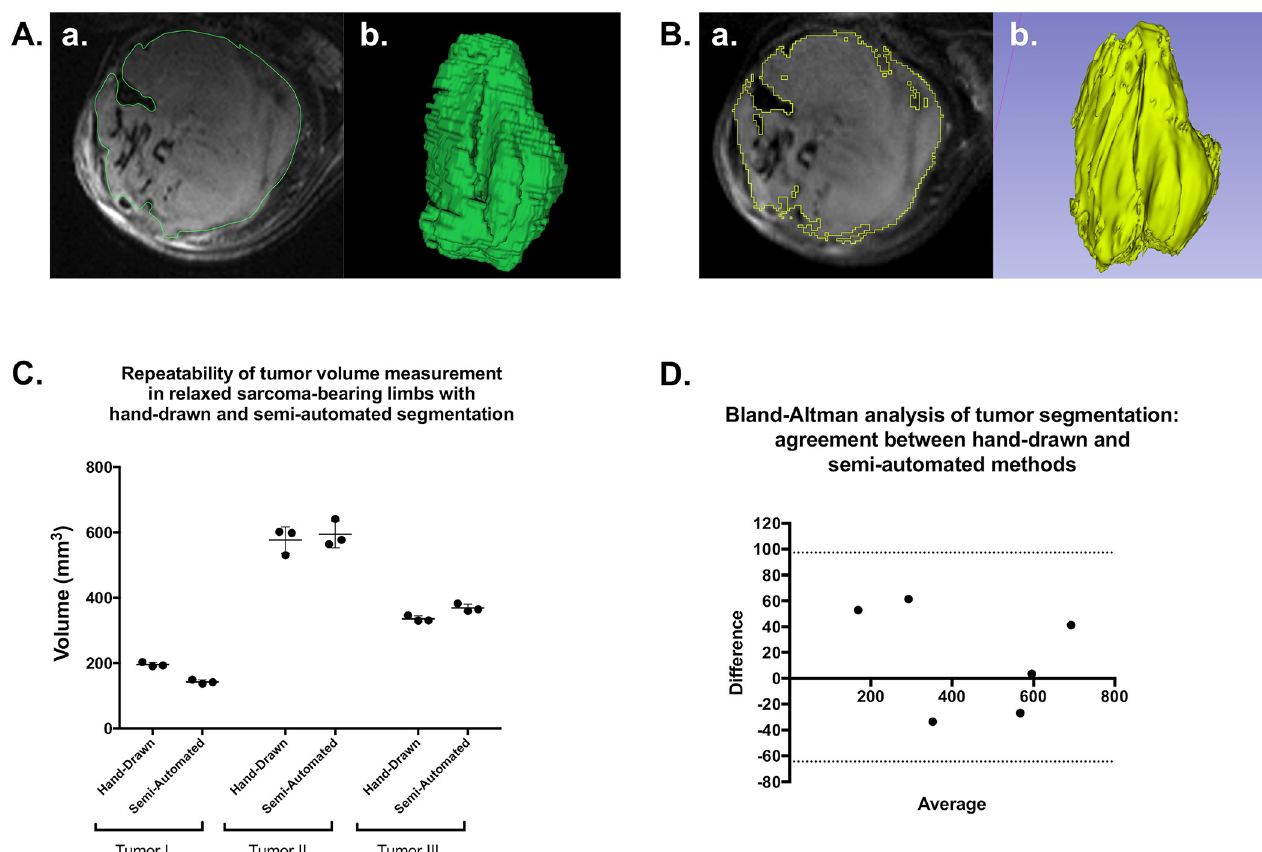
Fig 7. Semi-automated tumor segmentation with 3D Slicer is an acceptable alternative to hand-drawn ROIs for sarcoma volume measurement. T2-weighted images of three tumors of varying size and morphology were analyzed with hand-drawn ROIs and semi-automated segmentation to calculate tumor volume. Examples of hand-drawn (A) and semi-automated (B) segmentation of the same tumor are shown, including an axial slice of the segmented tumor (a.) and the rendered 3D representation of the tumor according to each segmentation (b.). Resulting volume calculations were compared between triplicate measures with each method for each tumor (C), demonstrating similar measurements and comparable precision. Bland-Altman analysis of both methods, when employed in 6 separate tumors, indicated that semi-automated segmentation is a viable alternative to hand-drawn segmentation (D).